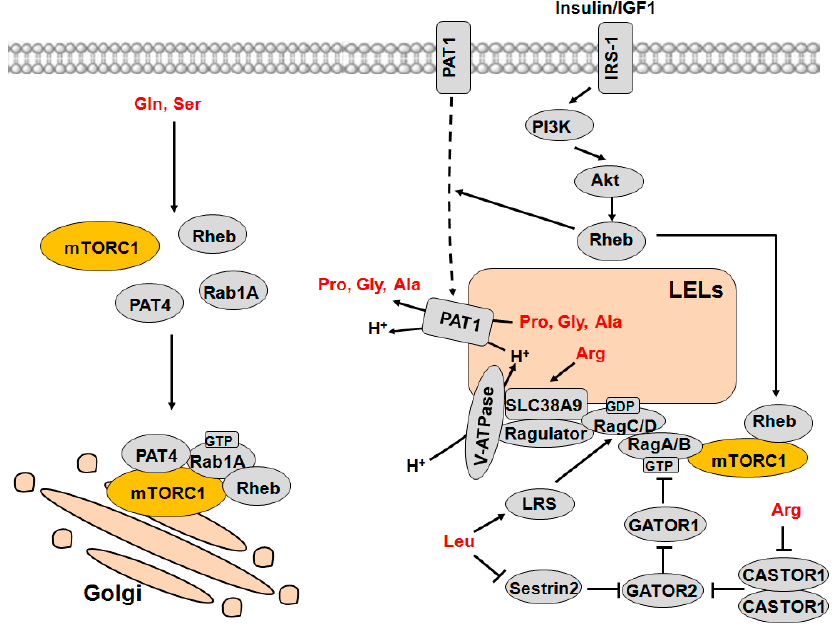
Figure 3. Model of AA-dependent activation of mTORC1 from LELs and Golgi apparatus. Multiple sensors are involved, including transporters (PAT1, PAT4 and SLC38A9) and cytosolic sensors (LRS, Sestrin2 and CASTOR1), which can sense specific AAs to activate mTORC1 on the surface of LELs or Golgi. Classically, mTORC1 is activated by AAs at LELs. Leucine activates Rag-mTORC1 by binding to LRS, which activates LRS GAP activity towards RagD, and by binding to Sestrin2, which inhibits Sestrin2-GATOR2 interaction. Arginine also promotes the activation of mTORC1 through binding to lysosome AA transporter SLC38A9 and CASTOR1. Activation of PI3K/Akt/Rheb signaling promotes the shuttling of PAT1 from the cell membrane to LEL membranes. PAT1 directionally transports AAs and protons out of the LELs coupled by the pumping of the protons back into the LEL lumen by v-ATPase, which subsequently leads to mTORC1 activation. Furthermore, AAs (perhaps glutamine and serine) also activate mTORC1 via stimulating interaction of AA transporter PAT4 with mTORC1 and its regulators Rab1A and Rheb on the Golgi. Arrows represent activation, whereas bars represent inhibition. AAs: amino acids; mTORC1: mammalian target of rapamycin complex 1; LELs: late endosomes and lysosomes; PAT1/4: proton-assisted AA transporters 1/4; LRS: leucyl-tRNA synthetase; CASTOR1: cellular arginine sensor for mTORC1; GATOR1/2: GAP activity towards Rags 1/2; PI3K: phosphatidylinositide 3-kinase; PKB/Akt: protein kinase B; Rheb: Ras homolog enriched in brain.